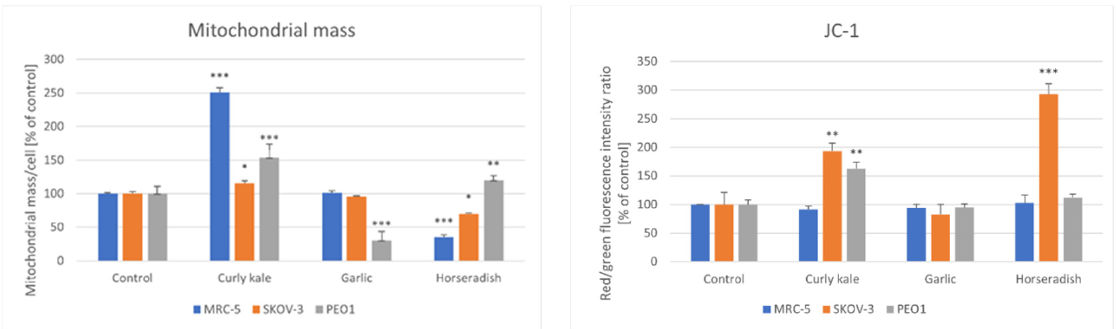
Figure 6. Effect of vegetable extracts on the mitochondrial mass and JC1 red/green fluorescence ratio as a measure of mitochondrial potential in PEO1, SKOV-3 and MRC-5 cells; * p < 0.05, ** p < 0.001, *** p < 0.001 (with respect to Control).